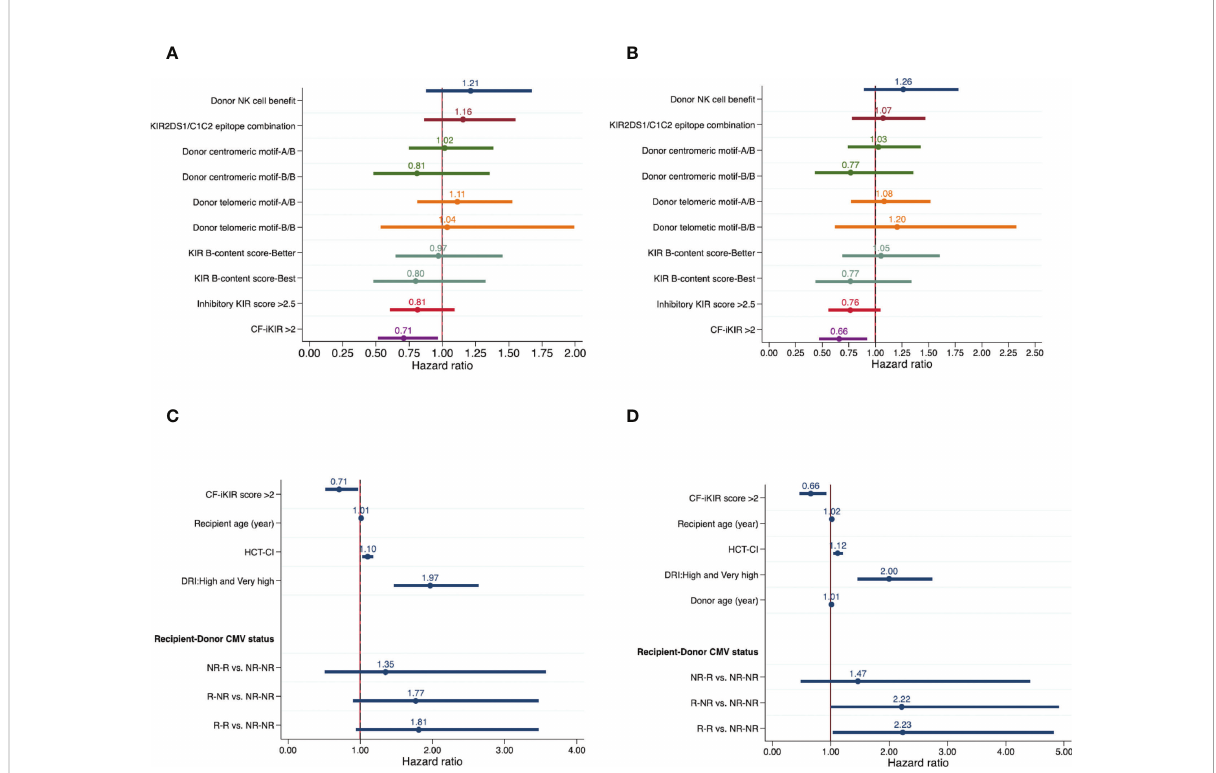
FIGURE 2 Effects of NK cell alloreactivity according to various models and patient and transplant-related factors on survival outcomes of patients who underwent haploidentical hematopoietic stem cell transplant (n = 354). Forest plots show effects of NK cell alloreactivity on progression-free survival (A) and overall survival (B) and effects of patient- and transplant-related factors on progression-free survival (C) and overall survival (D) , after adjustment for other signi fi cant baseline clinical factors. Abbreviations: NK, natural killer cells; KIR, killer cell immunoglobulin-like receptor; HCT-CI, hematopoietic cell transplant-comorbidity index; DRI, disease risk index; CMV, cytomegalovirus; NR, nonreactive; R,